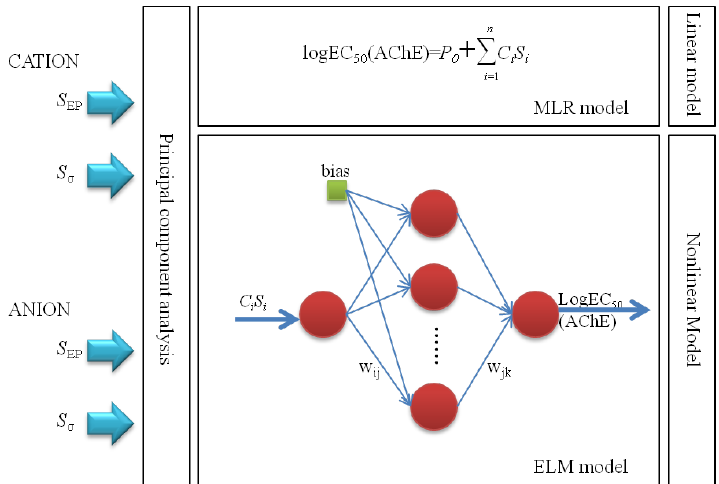
Figure 4. Scheme of linear and non-linear models programming methodology. The screening charge density distribution area ( S σ ) and the electrostatic potential surface area ( S EP ) of cations and anions were calculated employed to develop models optimal number of descriptors. The effective input descriptors were chosen by the stepwise regression approach and then the multiple linear regression (MLR) model was built with the obtained coefficients ( C i ) and selected descriptor ( S i ) to predict the the toxicity values (logEC 50 ) of ionic liquids (ILs) towards acetyl cholinesterase enzyme (AChE). The extreme learning machine (ELM) comprising three parts — the input layer, hidden layer, and output layer — was established based on the same input descriptors. The parameters w ij and bias from the input layer to hidden layer were generated randomly and the parameters w jk were coefficients from the hidden layer to output layer.